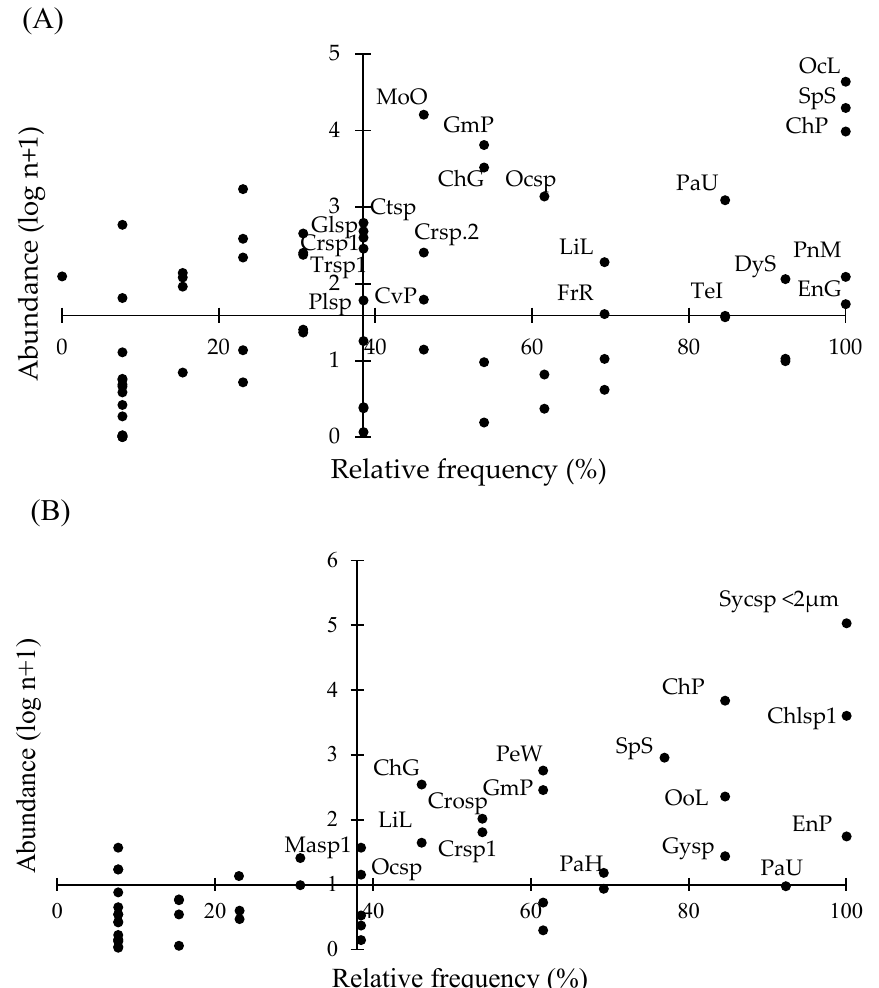
Figure 2. Bivariate [Olmstead–Tukey] diagrams of abundance (log n + 1) versus relative frequency (%) of the phytoplankton of Lakes ( A ) El Sol and ( B ) La Luna. (See species keys in Table 3). In the Olmstead–Tukey diagrams of both lakes, tycoplanktonic and truly planktonic forms were included among the representative (large abundance and high frequency of occurrence) taxa. The tychoplanktonic forms were Bacillariophyceae ( Cavinula pseu- docutiformis , Pinnularia microstauron , Encyonema gracile , Frustulia rhomboides , Encyonema perpusillum , Psamotidium helveticum ), Coleochaetophyceae ( Chaetosphaeridium globosum ), and Chrysophyceae ( Dinobryon cf. sociale ). The truly planktonic forms were Chlorophyceae with pods (e.g., Oocystis lacustris , Sphaerocystis schroeteri , Gemellicystis planctonica , Gloeocystis sp. Monoraphidium obtusum ), which gives buoyancy and grazing protection, and the podless Synechocystis sp. in Lake La Luna. Representative species of Dinophyceae, Chrysophyceae, Synurophyceae, Chlorophyceae, Cryptophyceae, and Euglenophyceae have flagellum (e.g., Chrysochromulina aff. parva , Parvodinium umbonatum , Peridinium willei , Gimnodinium sp., Trachelomonas sp. 1, Carteria sp., Chlamydomonas sp. 1), which can move freely to seek food and protection.